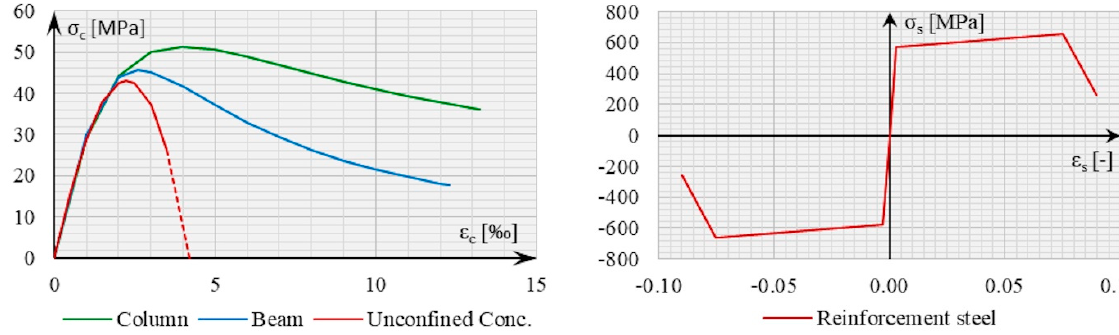
Figure 6. Material properties of concrete ( left ) and rebar ( right ).